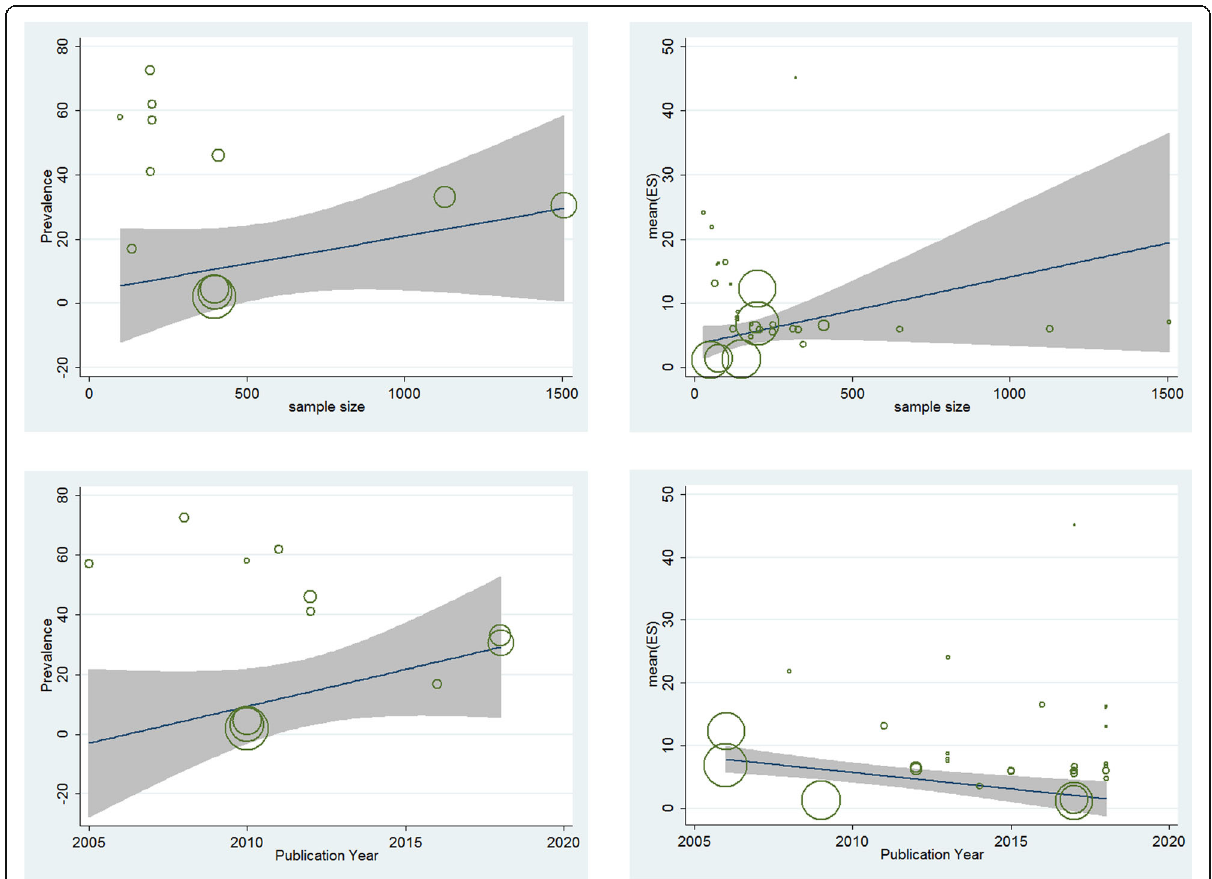
Fig. 4 The effect of different variables on heterogeneity between